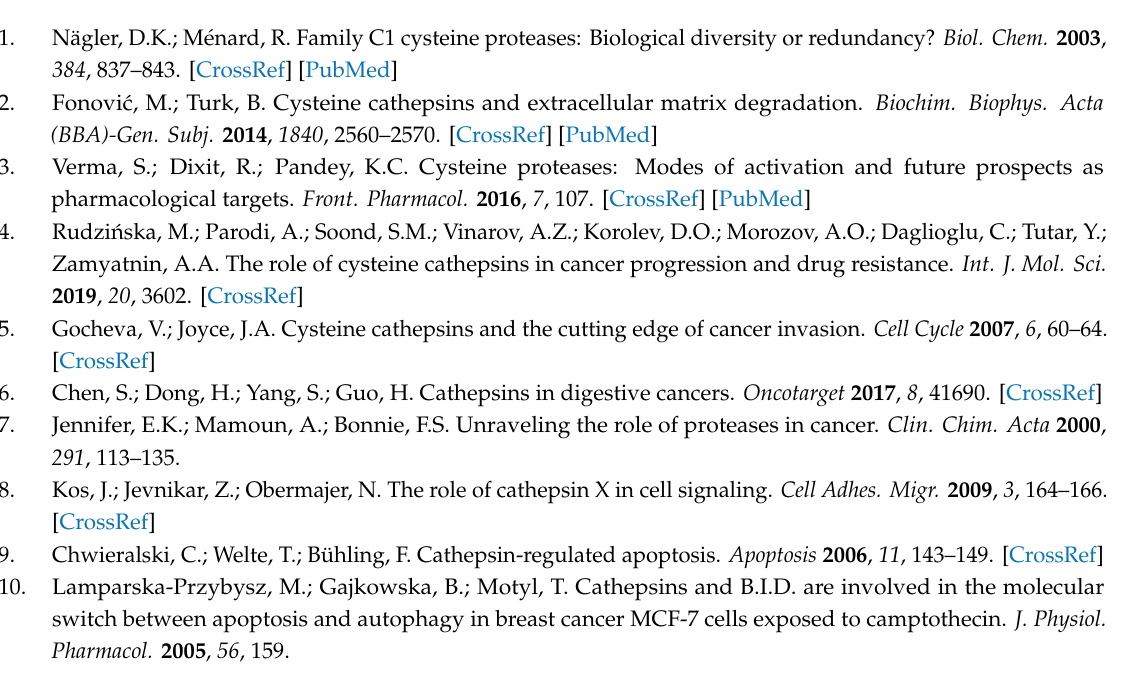
Figure S1: Detection of recombinant human CtsL and B activity through gelatin zymography assay. Recombinant purified human CtsL and B were loaded on the gelatin-gel zymogram. The Cts were activated through incubation of gel in an activating bu ff er (pH 4.8). Further staining with Coomassie brilliant blue G-250 showed the induction of proteolytic activity as bright white bands on dark background in correspondence with the bands of the enzymes, Figure S2. Determination of the peptide inhibitory properties against human purified CtsB and L. The activities of human recombinant CtsB and L, were measured via fluorimetric analysis by exploiting the fluorogenic properties of the Triticain- α substrate Ac-PLVQ-AMC. In the assay, the 20 nM of recombinant human CtsL and CtsB were incubated with 50 µ M substrate without Cts inhibitors (red line) and with Ac-PLVE-FMK and Ac-VLPE-FMK (blue and green line, respectively) at a concentration of 2 µ M. Fluorescence was measured as relative fluorescence unit (RFU), Figure S3. Combined e ff ect of PXT and the inhibitors on 769-P proliferation: 769-P cells were treated with 100 nM of PXT alone or in combination with 20 µ M of Ac-PLVE and Ac-VLPE and cell proliferation was measured after 24, 48, and 72 h via MTT assay. Data represent the mean ( ± S.D.) of three independent experiments, each performed in triplicate, Figure S4. Spheroids size and circularity: ( a , b ) size and circularity of 769-P and ( c , d ) A498 cells upon treatment with Ac-PLVE-FMK and Ac-VLPE-FMK. Data represent the mean ( ± S.D.) of three independent experiments, each performed in triplicate, Figure S5. E ff ect of Cts inhibitory peptides on cell sti ff ness: representative optical phase contrast image of cells (first row) and sti ff ness maps determined by indentation (Young’s modulus) of 769-P cells (second row) with and without treatment with PLVE and VLPE. Calibration bars represent 25 µ m. The graph shows the values of Young’s modulus of all analyzed samples, data are expressed as mean ( ± S.D.) and significance was calculated through one-way ANOVA followed by Dunnet’s test. * = p < 0.05, ** = p < 0.01, Figure S6. The e ff ect of the peptide inhibitors on human 769-P and A498 renal cancer cell on lysosomes integrity. ( a ) 769-P and ( b ) A498 cells were treated with increasing doses of Ac-PLVE-FMK (red bars) and Ac-VLPE-FMK (blue bars) (2.5–250 µ M). NR uptake was measured after 24, 48, and 72 h via MTT assay. ( c ) LysoTracker red evaluation in 769-P and ( d ) A498 cells after 24, 48, and 72 h with the inhibitors (20 µ M). Data represent the mean ( ± S.D.) of at least three independent experiments, each performed in triplicate, Figure S7. Uncropped western